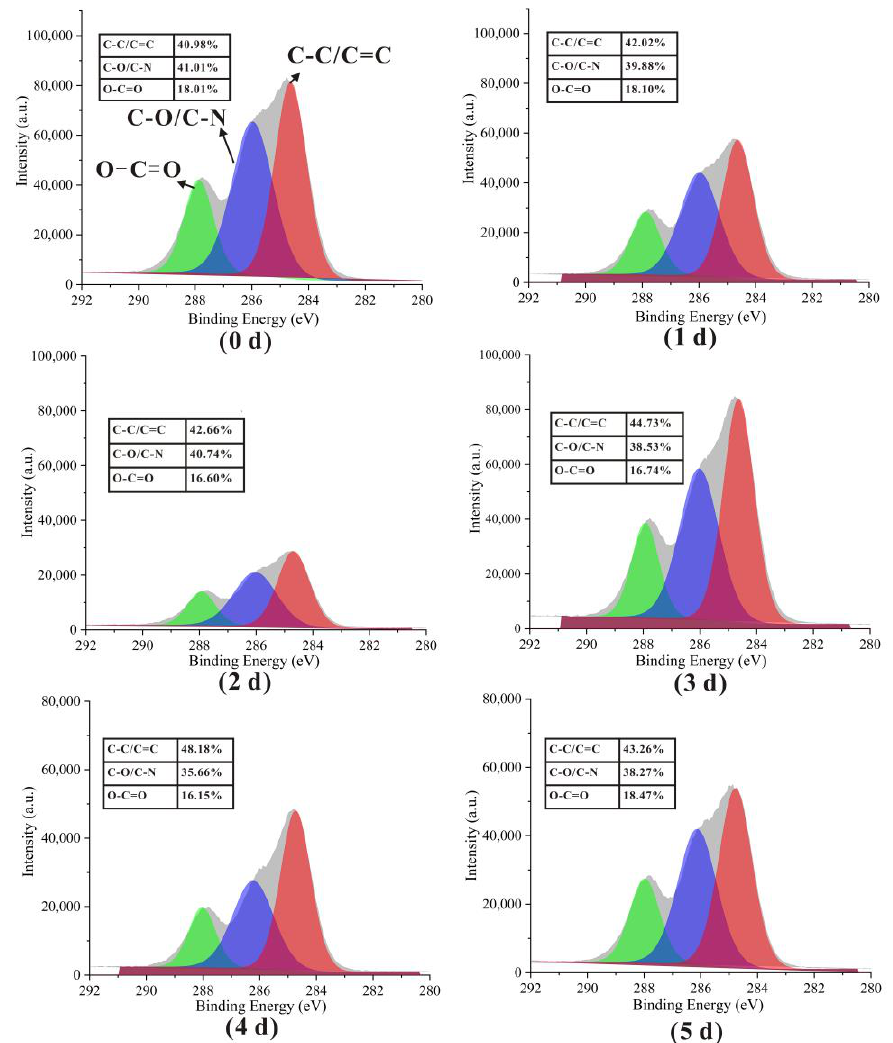
Figure 9. High-resolution C1s XPS spectra of gelatin/zein/glucose nanofibers after Maillard reactions conducted at 60 °C and 50% RH for 0~5 days.